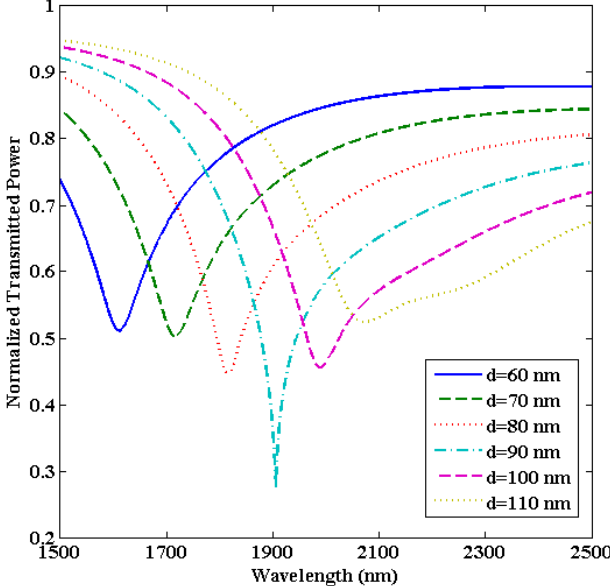
Figure 5. Transmitted LMR spectra (only the first LMR curve) for various thicknesses of the ITO film coated over the U-shaped fiber optic sensing probe. Here, SMRI = 1.33, L = 0.5 cm, and R = 1.0 cm.